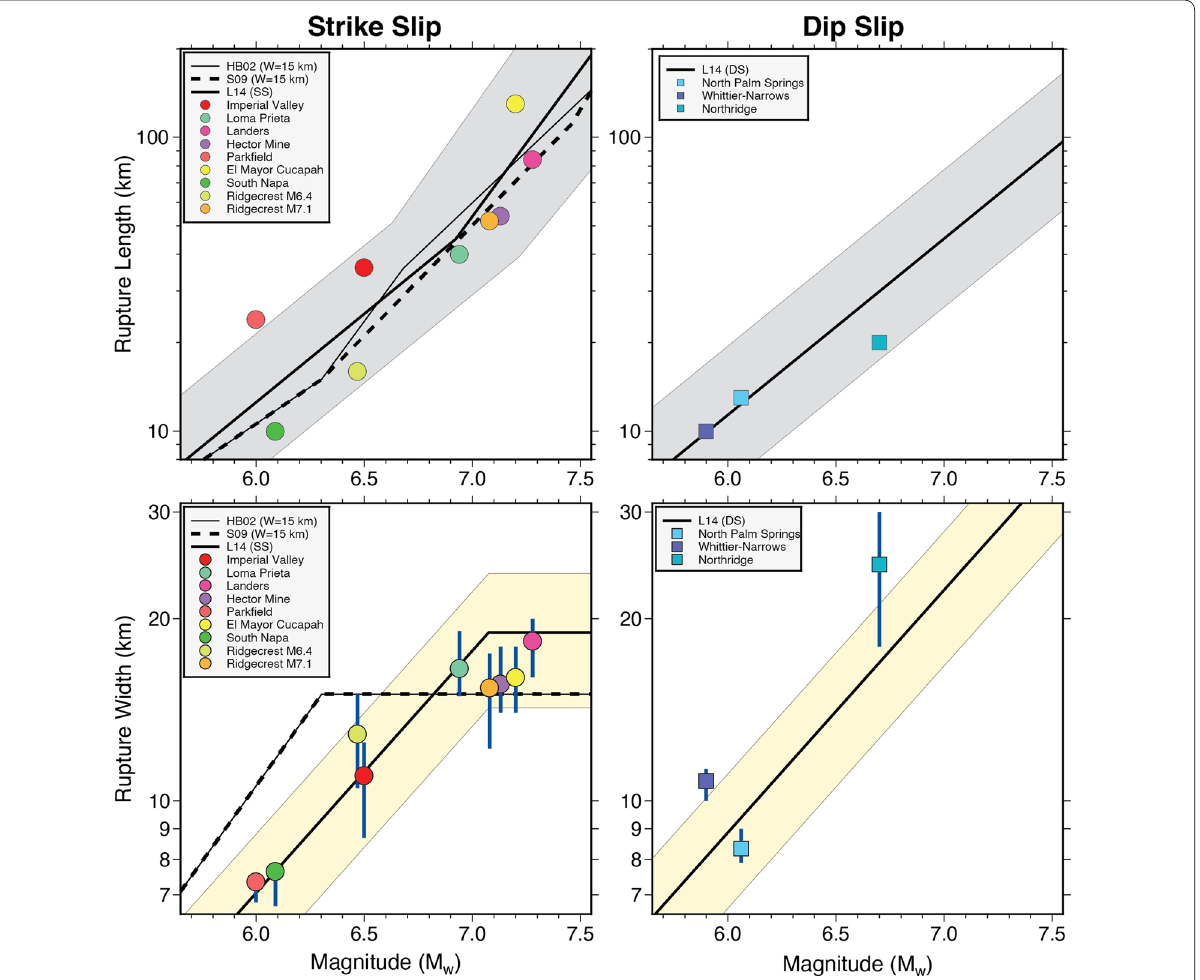
Fig. 13 Comparison of rupture length (top row) and mean rupture width (bottom row) for the five lowest misfit realizations for each of the 12 validation events with published relations: HB02 is from Hanks and Bakun (2002), S09 is from Shaw (2009), and L14 is from Leonard (2014). The events are further divided into strike- and oblique-slip (left column) and reverse-slip (right column). The gray shading in the rupture length panels indicates the standard deviation estimate from L14, and the yellow shading for the rupture width panels indicates the simulations. For rupture width, symbols are plotted at the mean value and the vertical bars indicate the minimum and maximum widths across the five lowest misfit realizations. Rupture length is not varied across